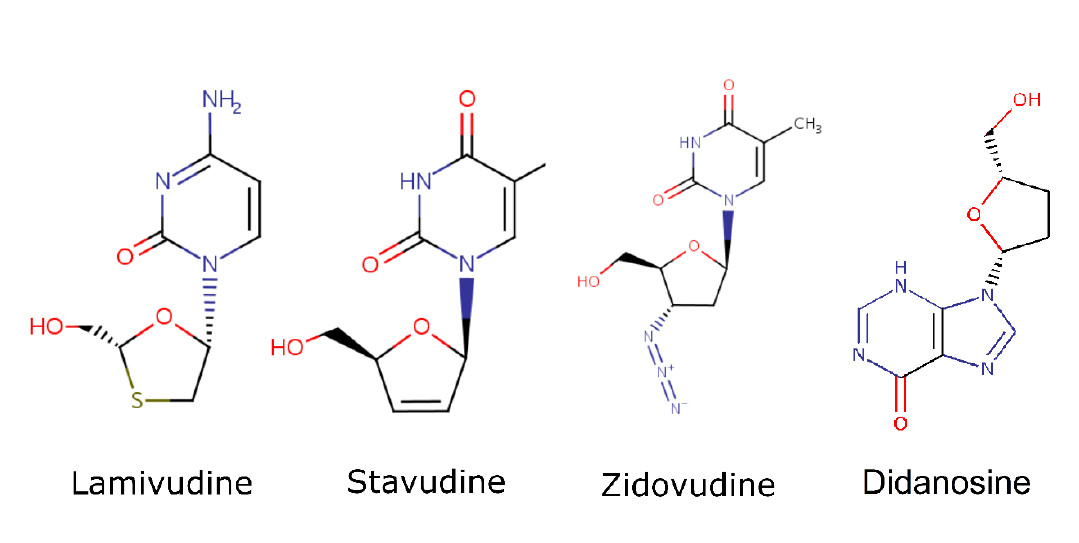
FIGURE 1 – Chemical structures of the antiretroviral drugs used in this study. Didanosine was used as internal standard (FDA,